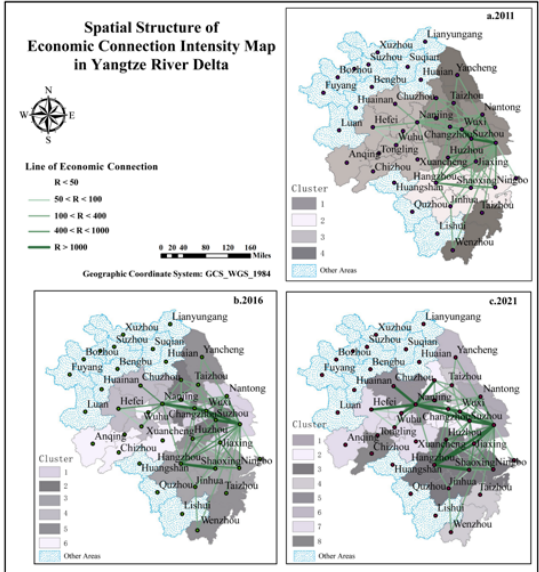
Figure 2. Spatial structure of economic connection intensity map in Yangtze river delta.